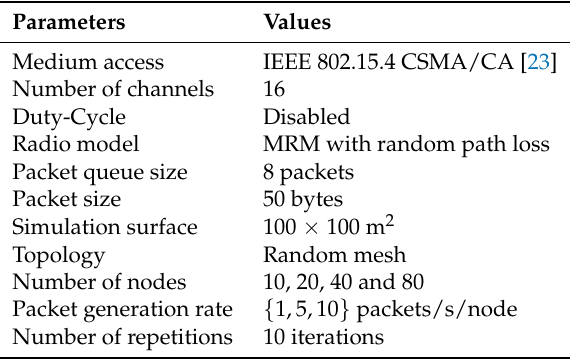
Table 1. Simulation